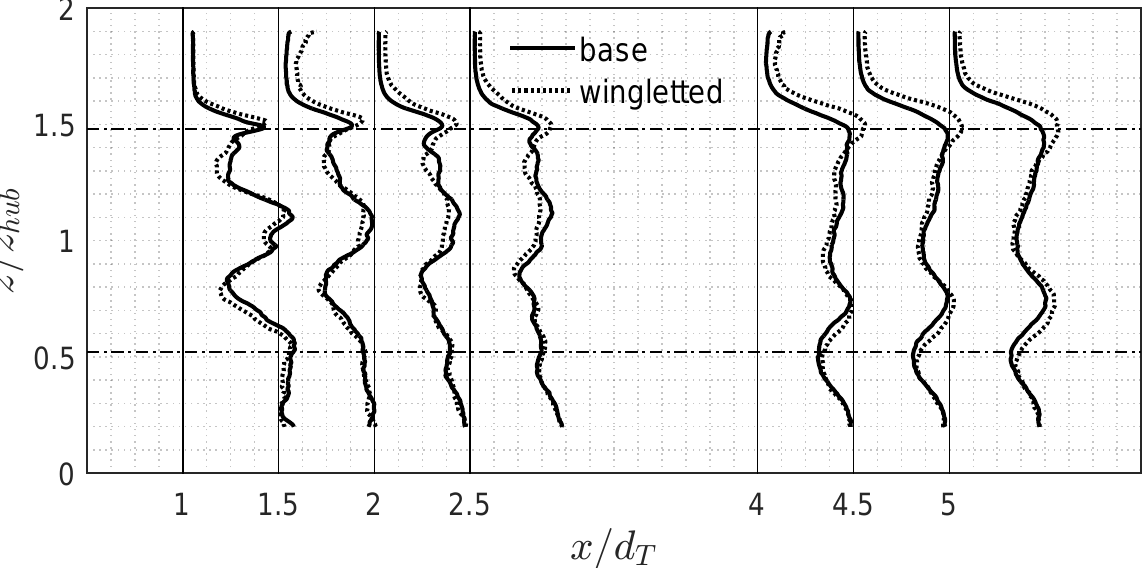
Figure 8. Comparison of the standard deviation of velocity profiles at the central plane of the standard and wingletted turbine models at several downstream locations. Horizontal dash-dot lines indicate the location of the bottom and top tips of the turbine. Vertical solid lines indicate local zeros, and grid squares have a width of 0.025 × U hub